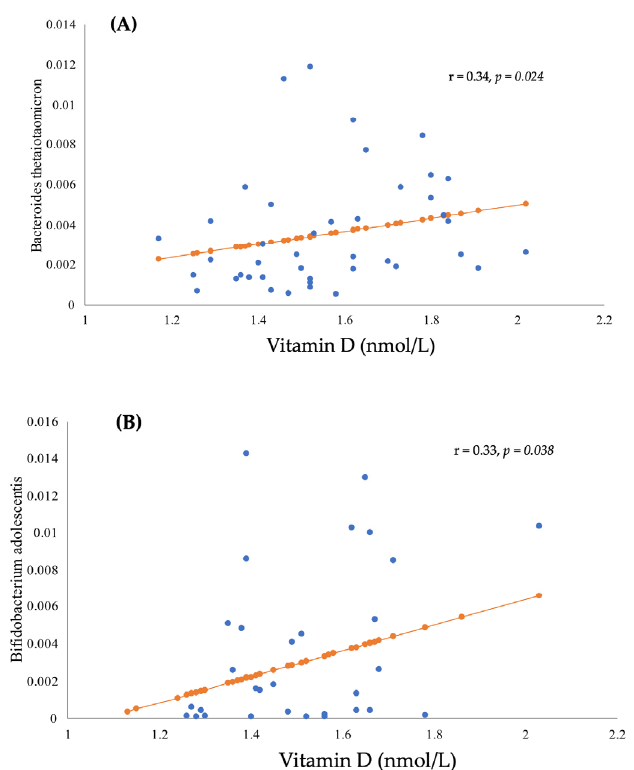
Figure 1. Associations between serum vitamin D and gut microbiota relative abundance ( A ) Association between serum vitamin D and Bacteroides thetaiotaomicron species in participants with normal weight (controls). ( B ) Association between serum vitamin D and Bifidobacterium adolescentis species in participants with obesity (cases).